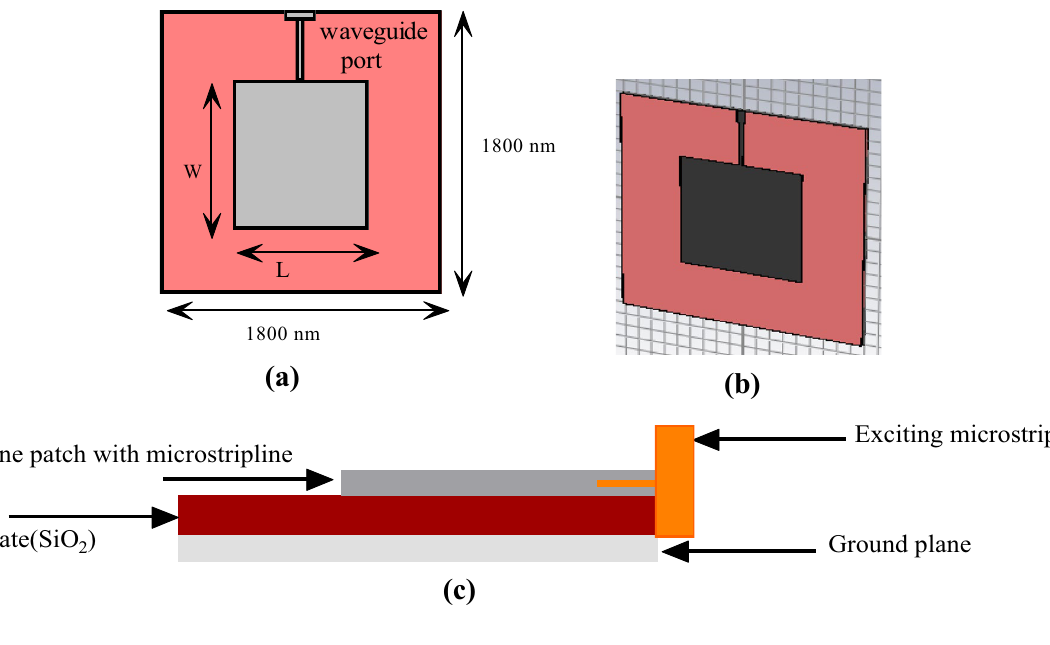
Fig. 1 Graphene nano patch antenna a 2D view b 3D view c side